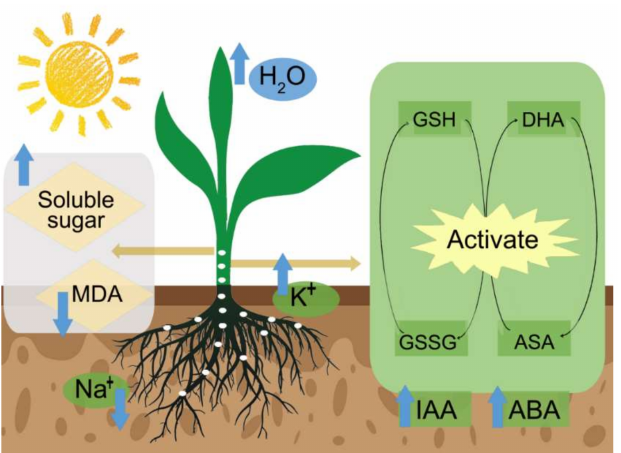
Figure 3. Mechanisms of PGPEB in salt stress alleviation. White dots represent the PGPEB in the plant. Under salt stress, endophytes coregulate the hormone balance, including increasing IAA and ABA contents and activating the ASA-GSH cycle, alleviating osmotic stress by increasing K + and Na + absorption, and alleviating oxidative